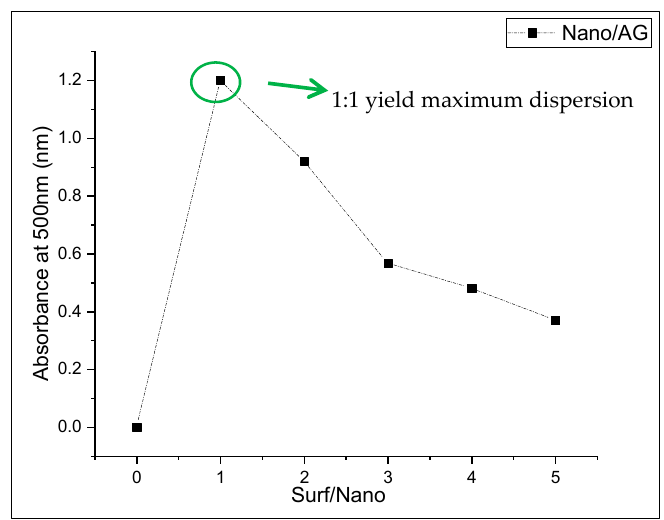
Figure 4. Absorbance of nanocomposite using AG as a surfactant.